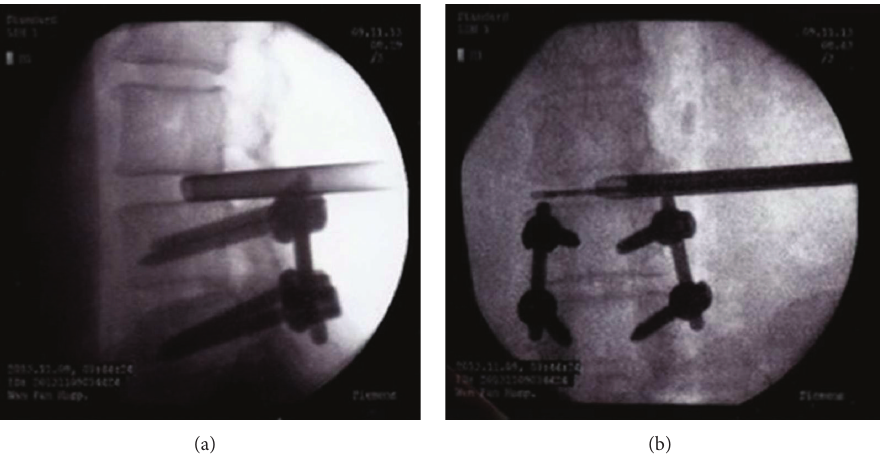
Figure 2: Fluoroscopic images taken intraoperatively. After insertion of endoscopic cannula (a), disc was removed using endoscopic forceps (b).